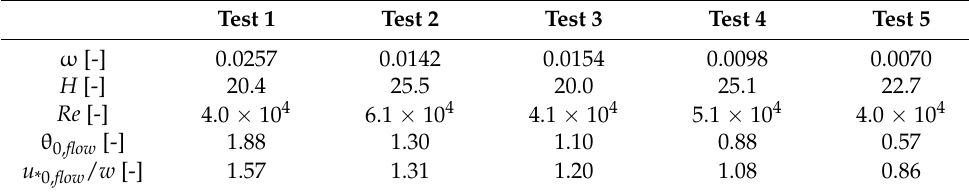
Table 2. Combined-load experiment in tilting flume: Experimental conditions for Tests 1 to 5 (longi- tudinal slope ω , flow depth H , flow Reynolds number Re , bed Shields parameter θ 0, flow , suspension ratio u *0, flow / w ; all quantities are